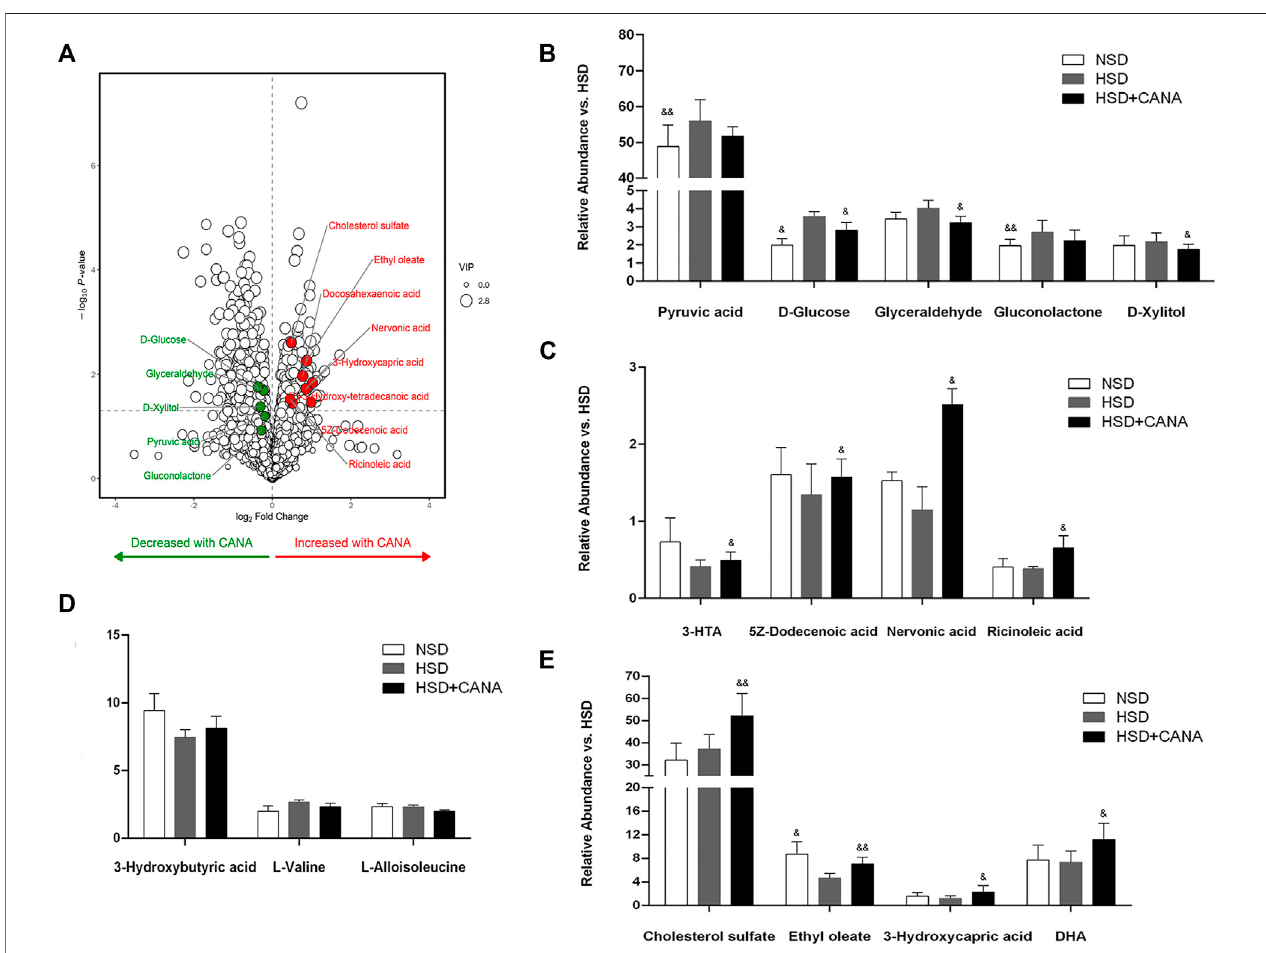
FIGURE 5 | Effect of CANA on metabolic pathways. (A) Volcano plot of cardiac metabolites altered by CANA, in comparison to HSD; (B – E) Representative catabolic metabolites. NSD, normal-salt diet; HSD, high-salt diet; 3-HTA, 3-hydroxy-Tetradecanoic acid; DHA, docosahexaenoic acid; & p < 0.05, && p < 0.01 vs. HSD.